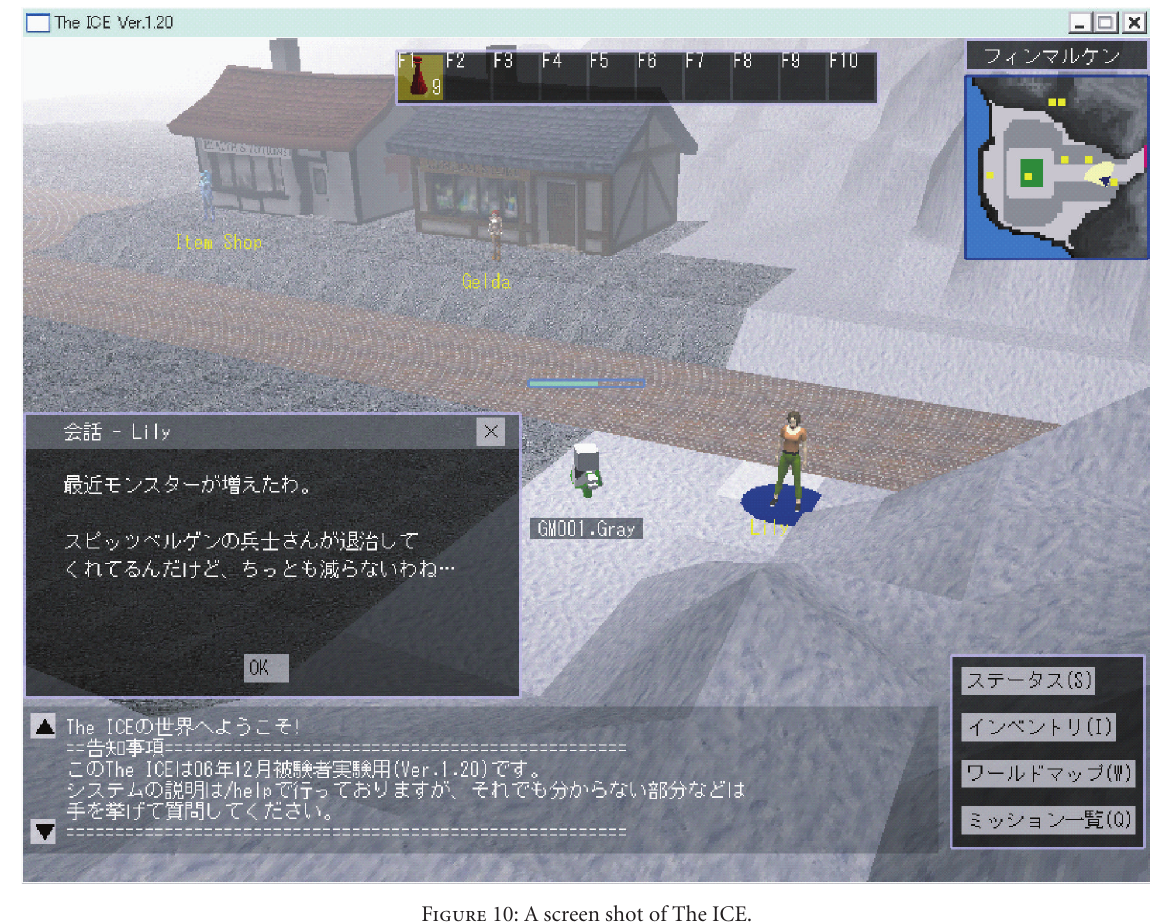
Figure 10: A screen shot of The ICE.